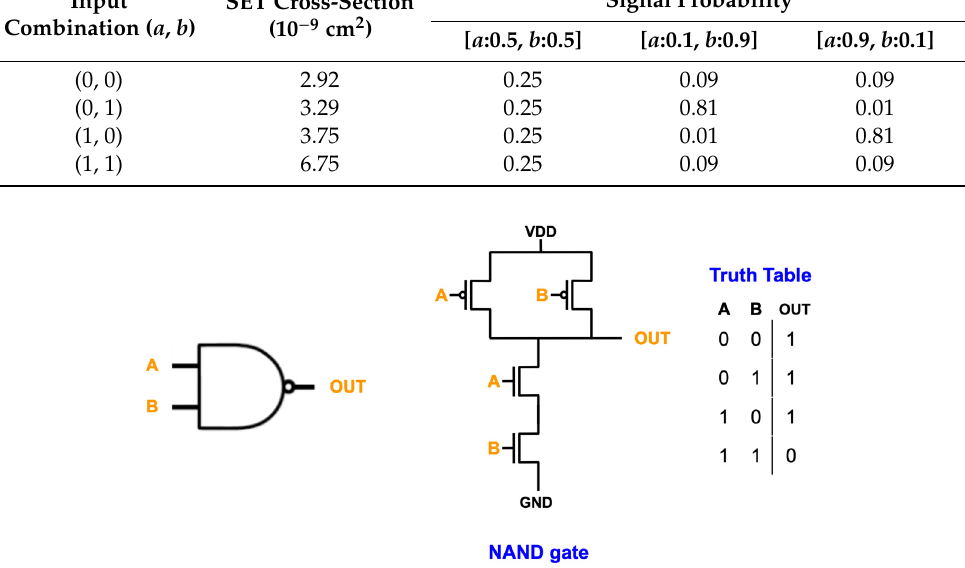
Figure 7. Gate-level and transistor-level representation of NAND2_X1 and its truth Figure 7. Gate ‐ level and transistor ‐ level representation of NAND2_X1 and its truth table.